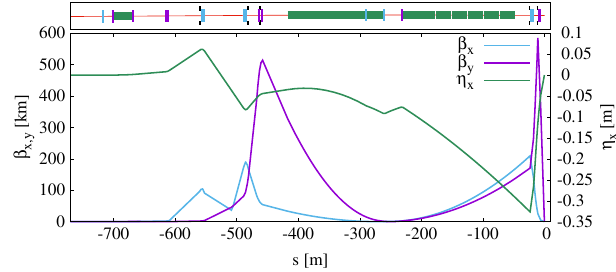
FIG. 1. Beta functions and dispersion function for the nominal L (cid:2) ¼ 6 m CLIC 380 GeV final-focus